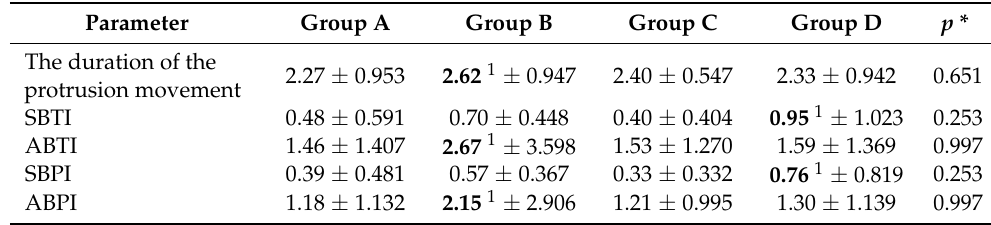
Table 9. Duration of protrusion movement according to associations between working and non- working